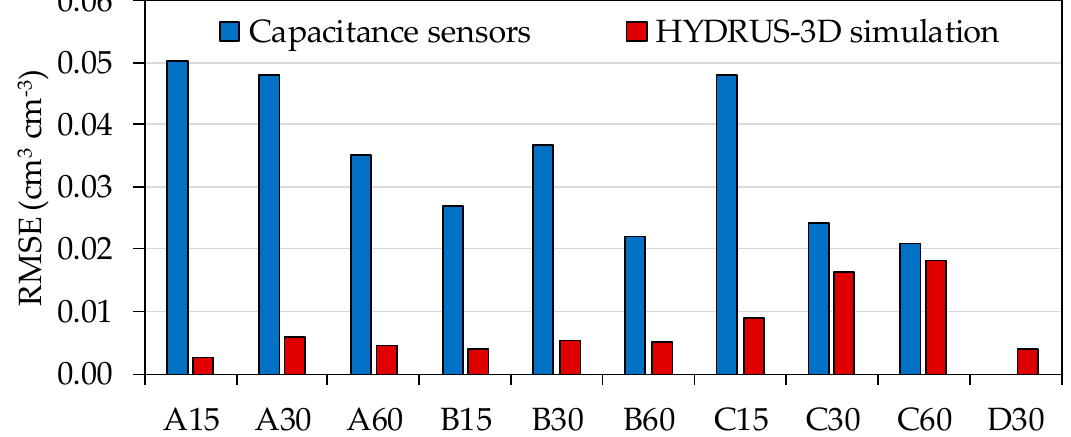
Figure 10. Sensor-to-sensor differences in SWC measured by capacitance sensors and by HYDRUS-3D simulations at the same soil positions ±10 cm in the direction to the dripper.